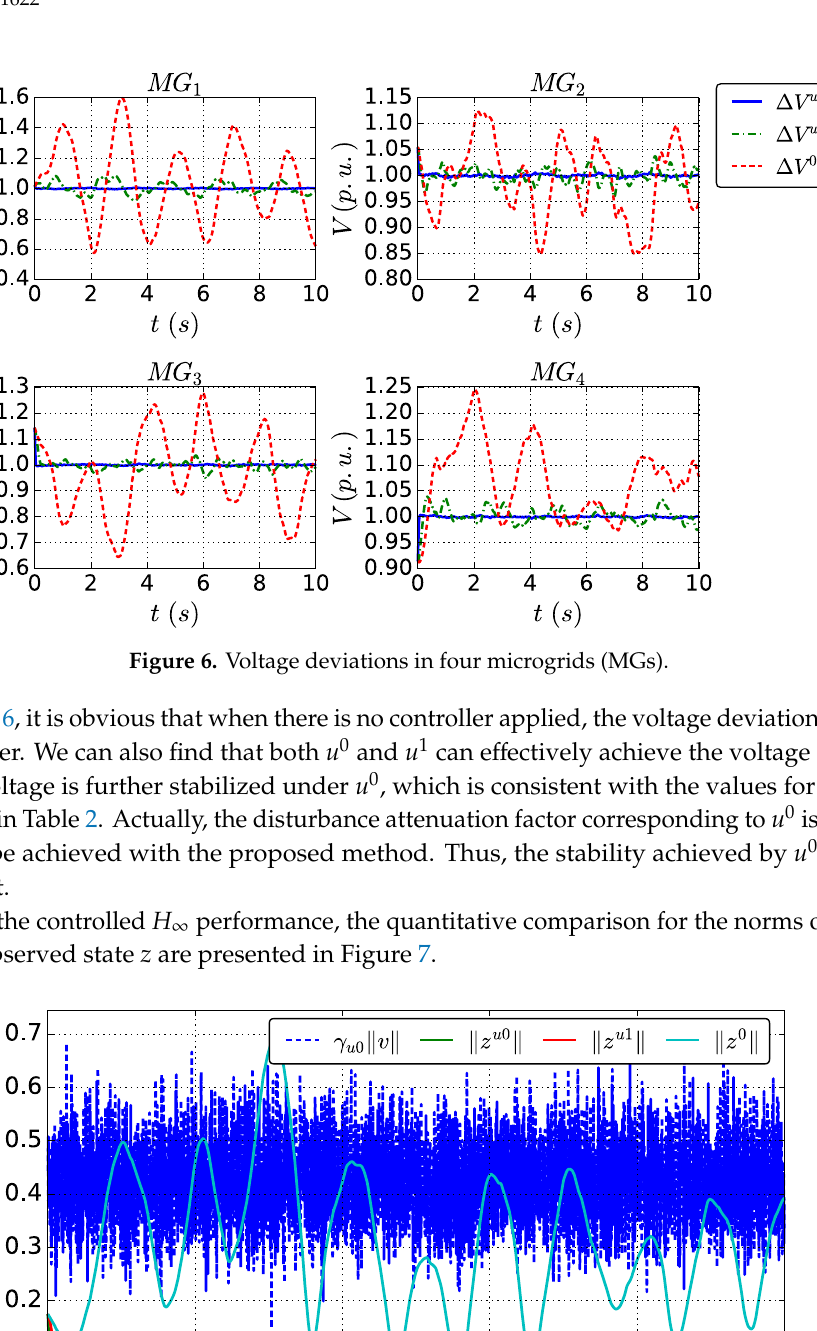
Figure 5. Power deviations of PVs, WTs and loads in 𝑀𝐺 (cid:2869) . Based on the curve of time delay 𝜏(𝑡) , factor for parameter uncertainties 𝐹(𝑡) and dynamics of PVs, WTs and loads, we are able to evaluate the effectiveness of the controllers obtained from problems (18) and (20) as follows. The voltage deviations in four MGs are illustrated in Figure 6. The dashed red curves in Figure 6 refer to the dynamics of voltage deviations when there is no controller applied to the EI system. The dynamics of voltage deviations in the four MGs under 𝑢 (cid:2868) and 𝑢 (cid:2869) are illustrated with solid blue lines and dashed–dotted green lines, respectively. As stated above, BESs and FESs in MGs are treated